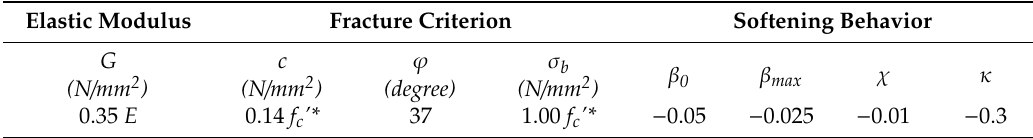
Table 2. Calibrated model parameters for shear